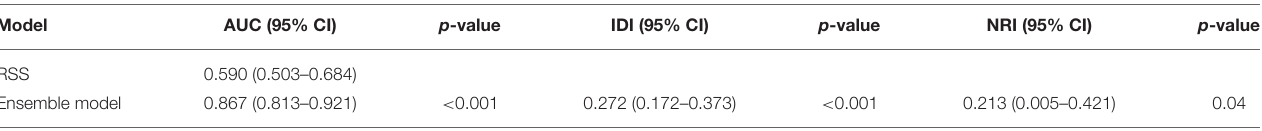
TABLE 3 | Comparison of performance for all-cause mortality prediction between the RSS and Ensemble model. Model